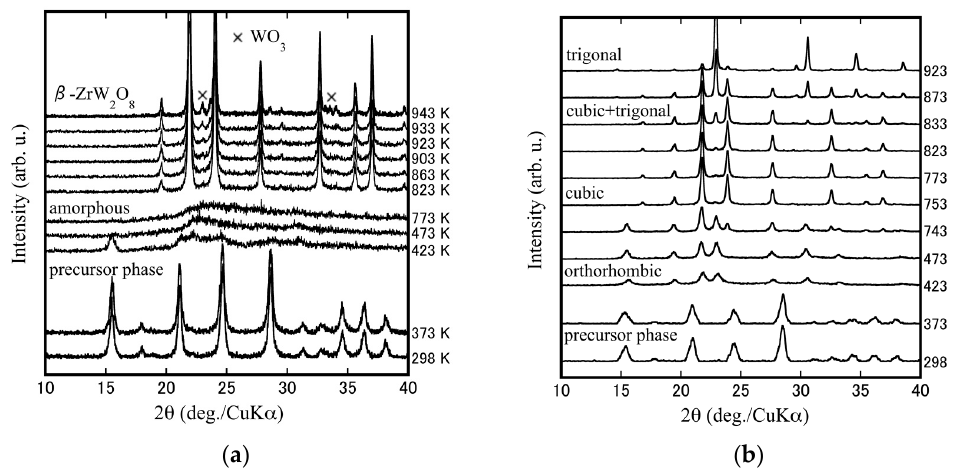
Figure 2. TG-DTA curves of the ZrW 2 − x Mo x O 7 (OH) 2 ·2H 2 O ( a ) x = 0.0; ( b ) x = 1.0 precursors.